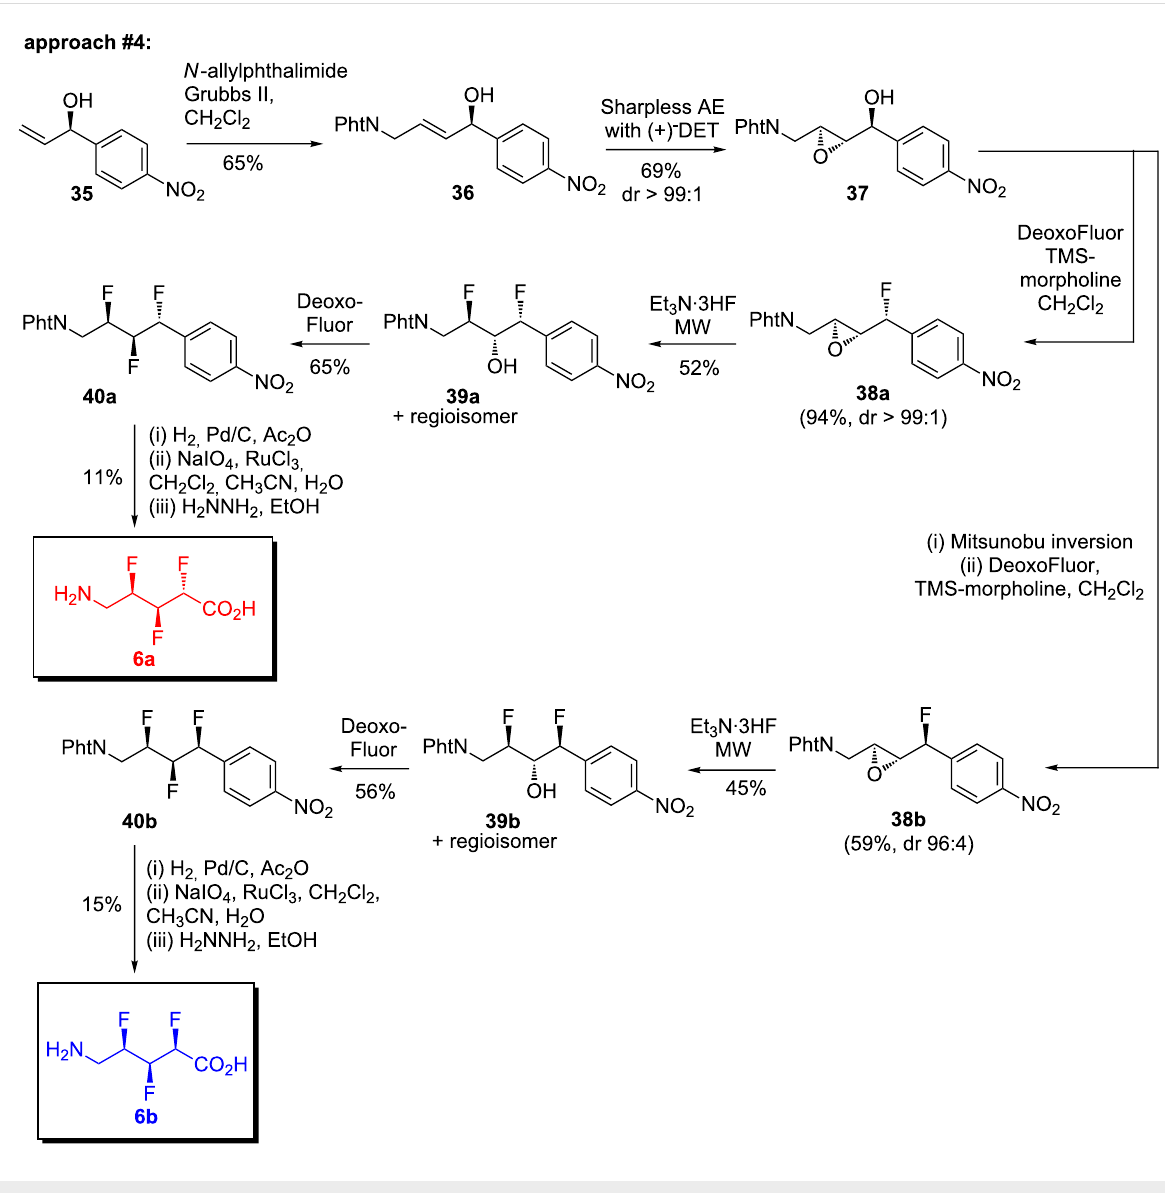
Scheme 4: The fourth synthetic approach (partially reproduced from ref.